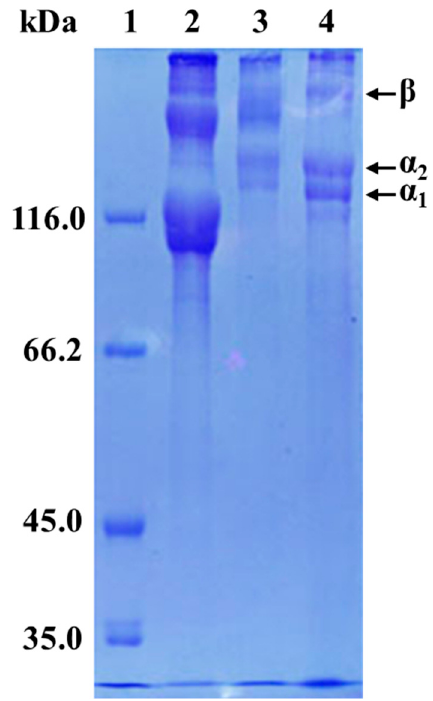
Figure 1. Sodium dodecyl sulfate-polyacrylamide gel electrophoresis (SDS-PAGE) patterns of collagens from surf clam shell ( Coelomactra antiquata ). Lane 1, molecular weight marker; Lane 2, Type I collagen from the skeletal muscle of grass carp; Lane 3, guanidine hydrochloride soluble collagen (GSC); Lane 4, pepsin soluble collagen (PSC).